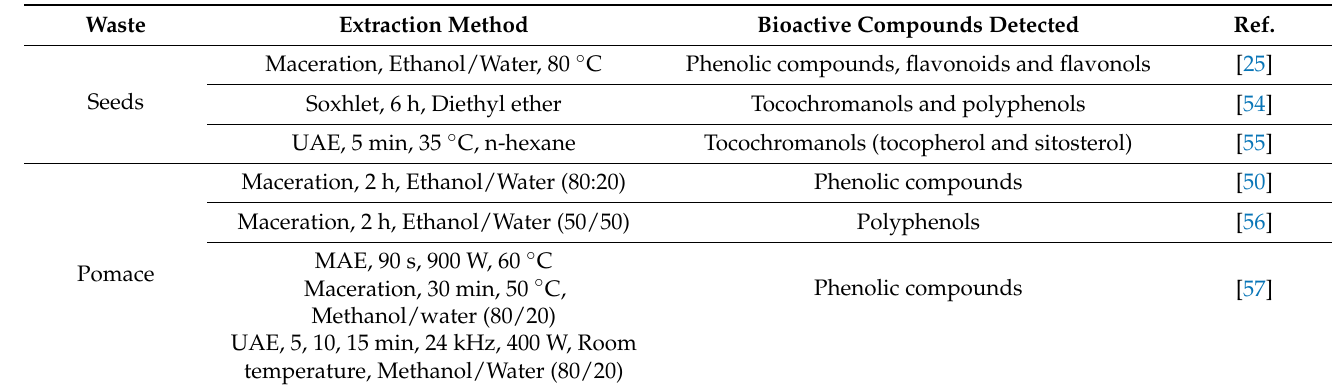
Table 5. Summary of different studies that have been conducted for the extraction of bioactive compounds from wastes of different cherry